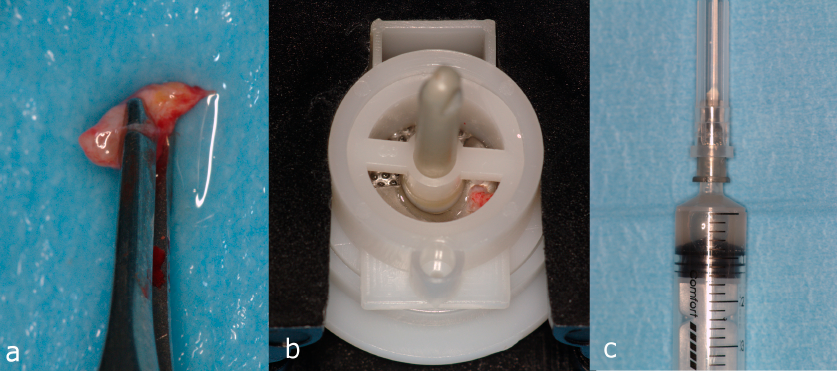
Figure 6. Micrograft suspension preparation in accordance with the Rigenera protocol. A connective tissue sample about 5 mm in length was collected directly from the surgical recipient site and washed with sterile saline ( a ); the sample was inserted in the Rigenera filter ( b ) to obtain the cellular graft enriched with hPCs ( c ).